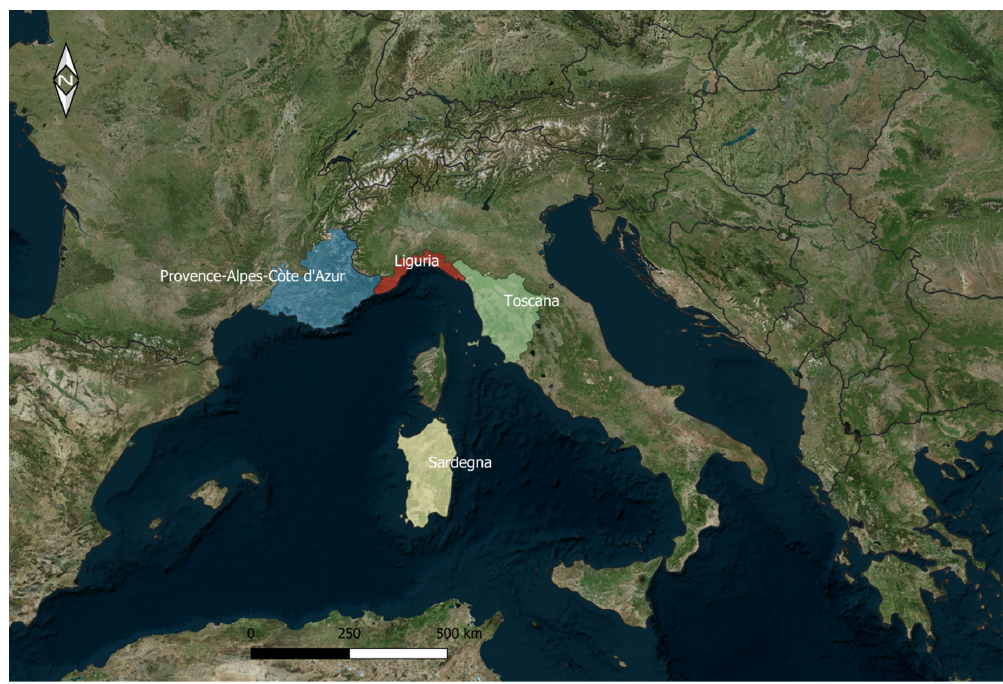
Figure 1. Geographical location of the investigated regions.